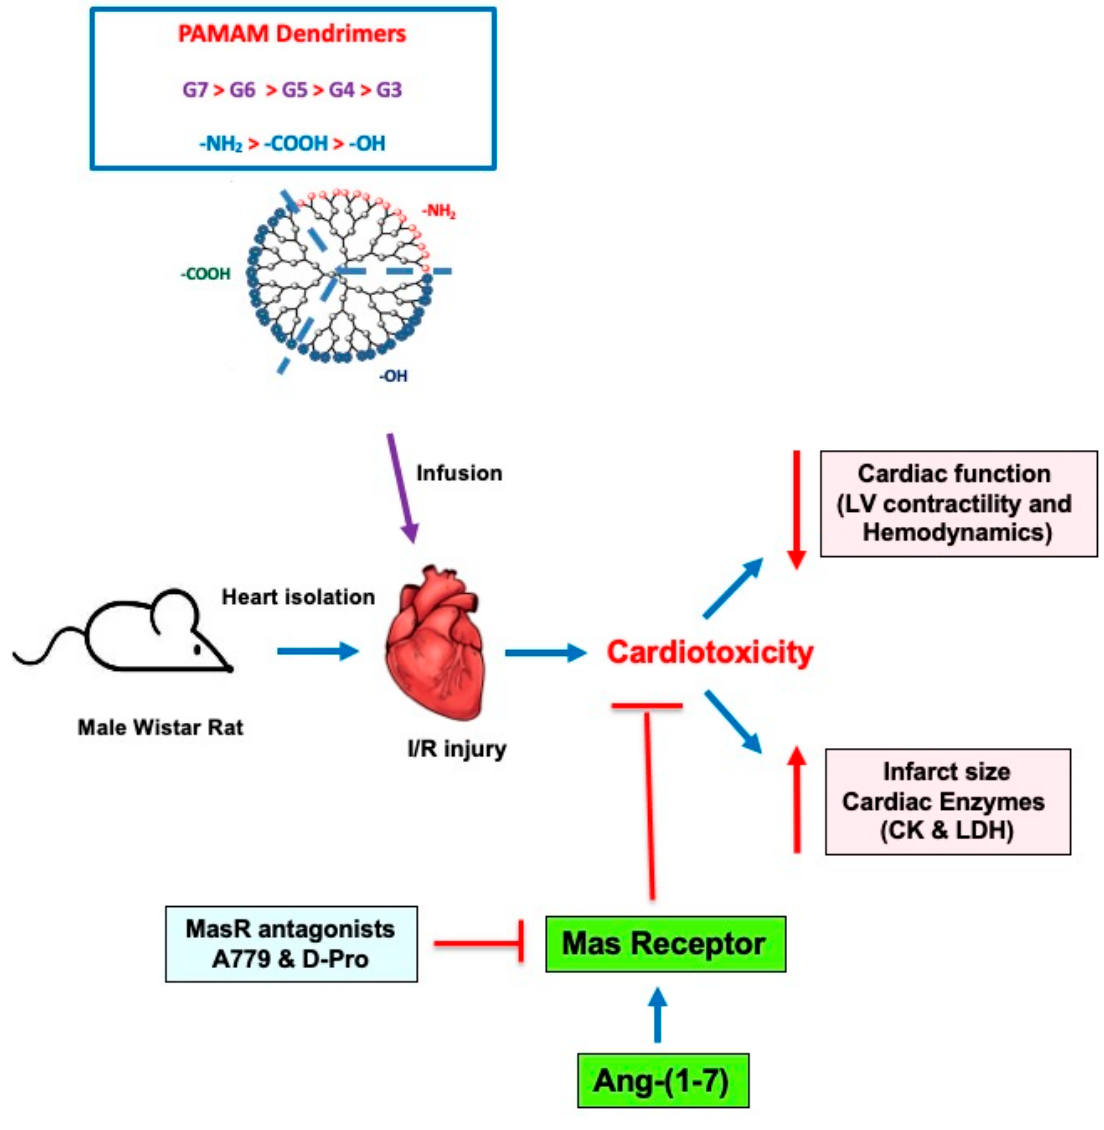
Figure 6. A schematic summary of the impact of different PAMAMs in the mammalian heart and the ability of Ang-(1-7) to mitigate their cardiotoxicity. In isolated rat hearts subjected to I/R injury, administration of PAMAM dendrimers exacerbated recovery of cardiac function in terms of LV contractility and hemodynamics parameters as well by increasing infarct size and cardiac enzyme levels (LDH and CK)—hallmarks of cardiac damage and toxicity. These effects of PAMAMs were dependent on dendrimer generation (G7 > G6 > G5 > G4 > G3) and surface charge ((-NH 2 (cationic) > -COOH (anionic) > -OH (neutral)). The adjunct administration of Ang-(1-7) rescued the cardiotoxicity caused by cationic PAMAM dendrimers. The beneficial effects of Ang-(1-7) were revoked by two Mas receptor (MasR) antagonists (A779 and D-Pro), confirming that Ang-(1-7) actions were, at least in part, mediated through MasR. Thus, Ang-(1-7) may represent a viable strategy to mitigate the cardiotoxicity of PAMAM dendrimers.